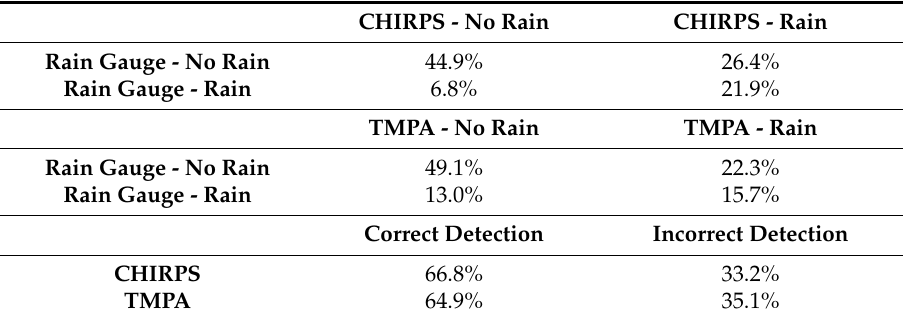
Table 1. Rain–no-rain validation study results for daily precipitation from 2000–2014.